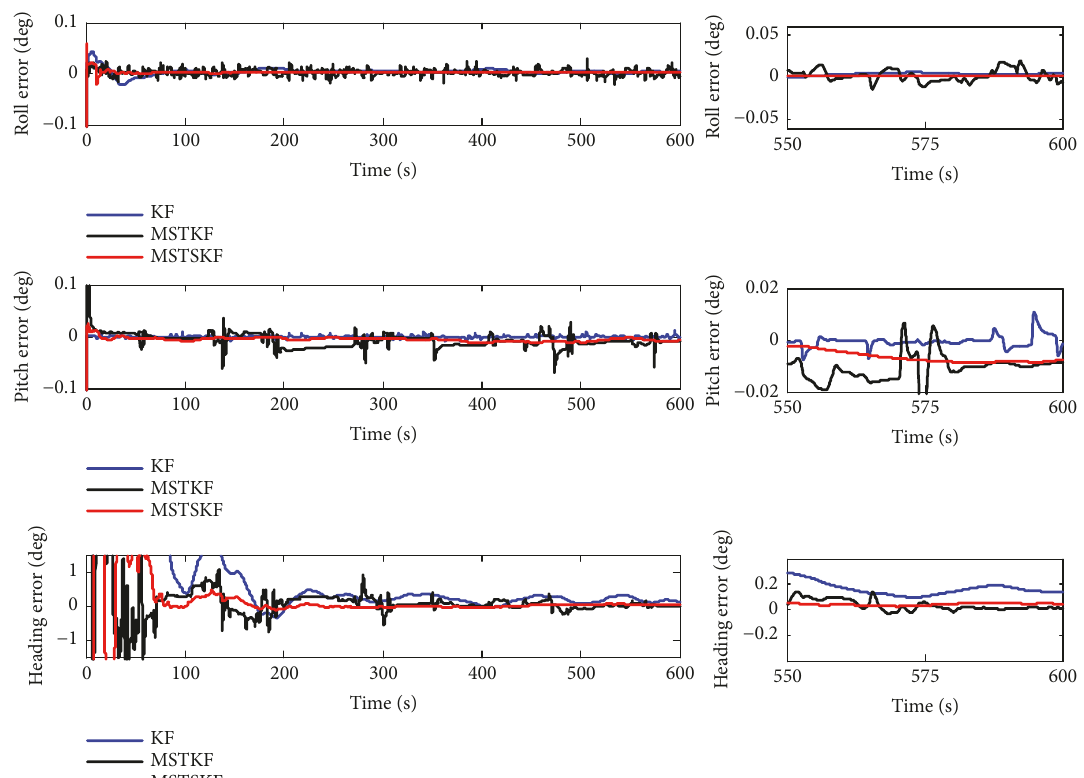
Figure 3: Attitude angle error of the simulation when the noise of Z-axis accelerometer increases to 50